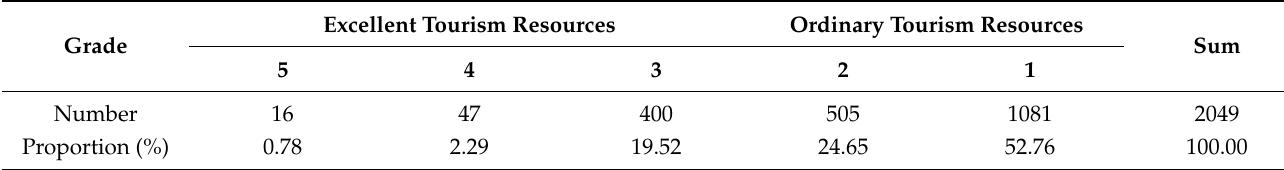
Table 2. Grade distribution of tourism resources in Longde